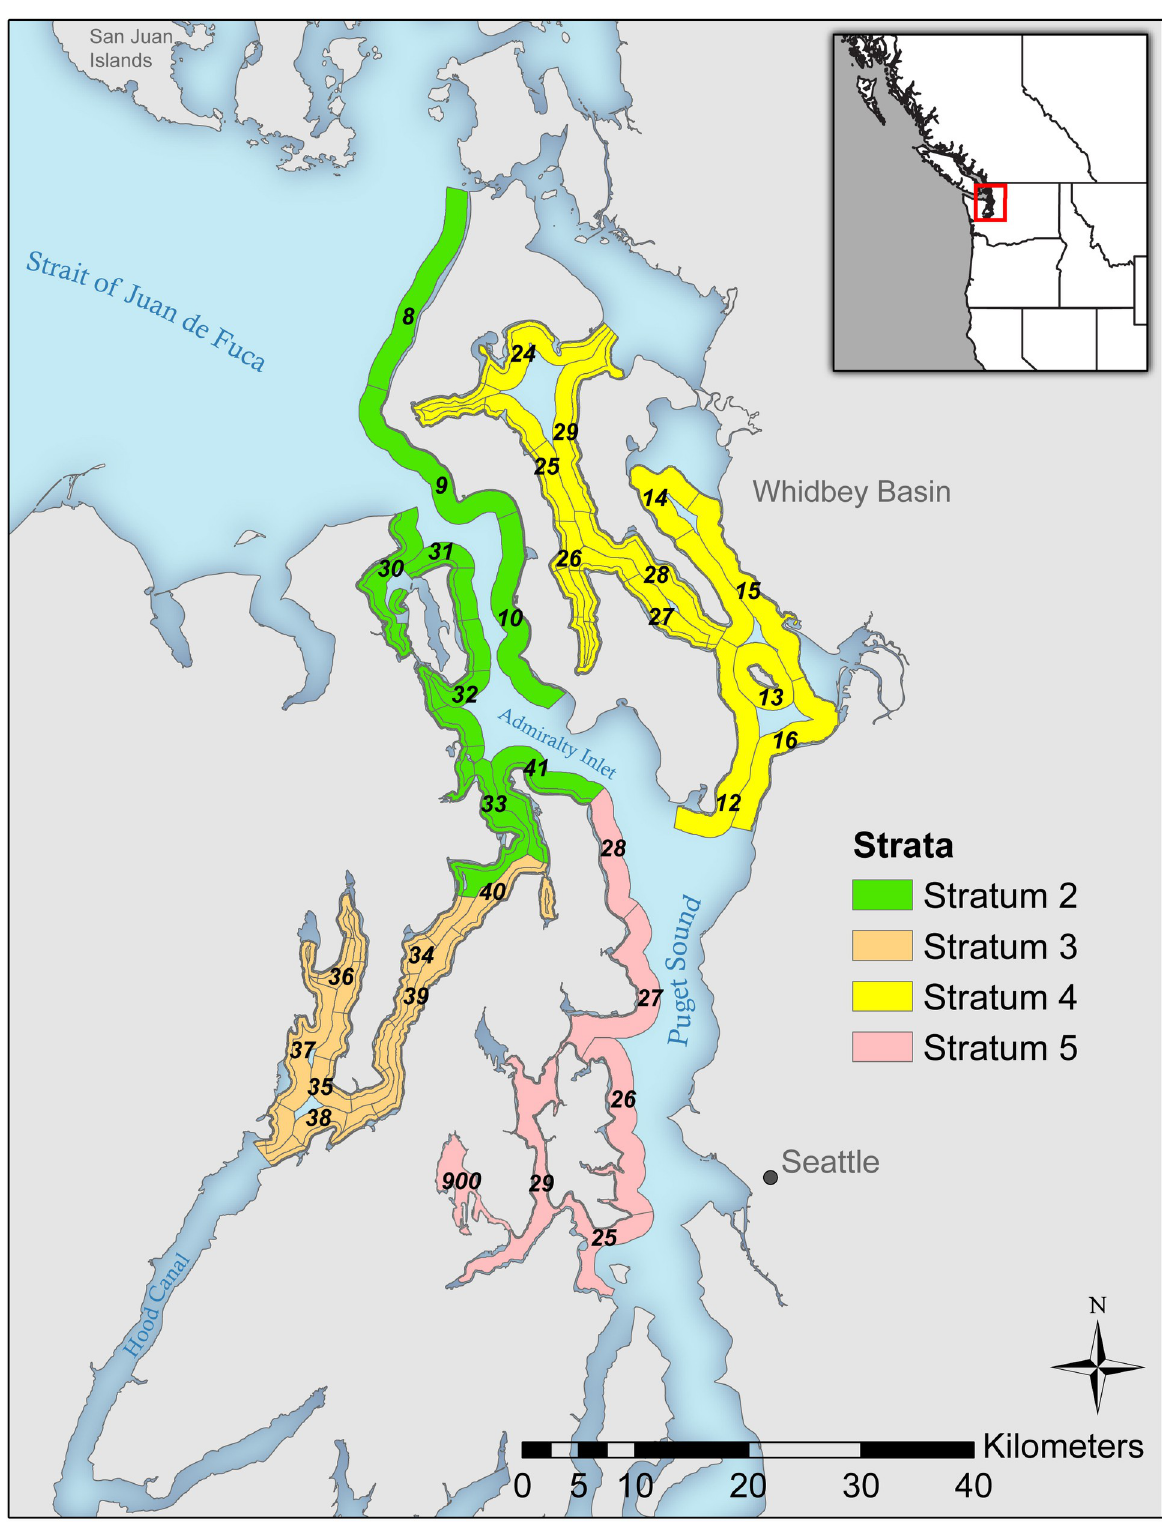
Fig 1. Survey area and design. Stratum and primary sampling unit (PSU) locations in Puget Sound. Strata are defined in the legend and PSUs are numbered on the map.